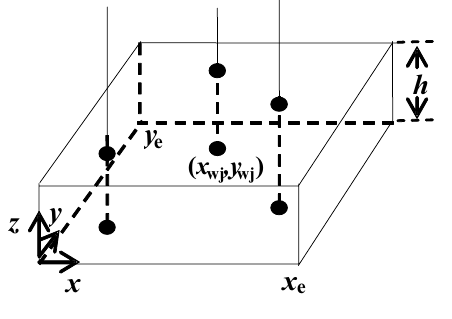
Fig. 1 The physical model of gas